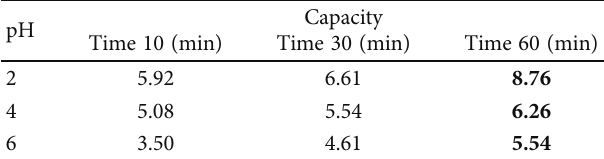
Table 3: The amount of cadmium that was adsorbed with the change of the acidity function and the immersion time in a solution of 60ppm.